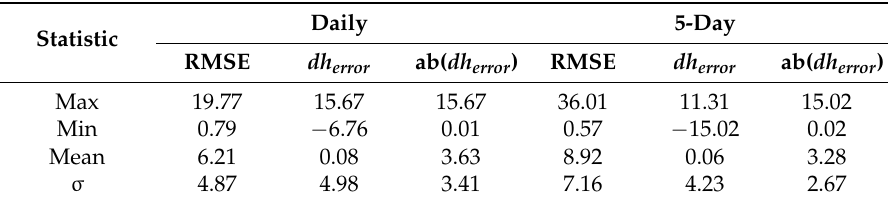
Table 4. Statistic of the objective function for the